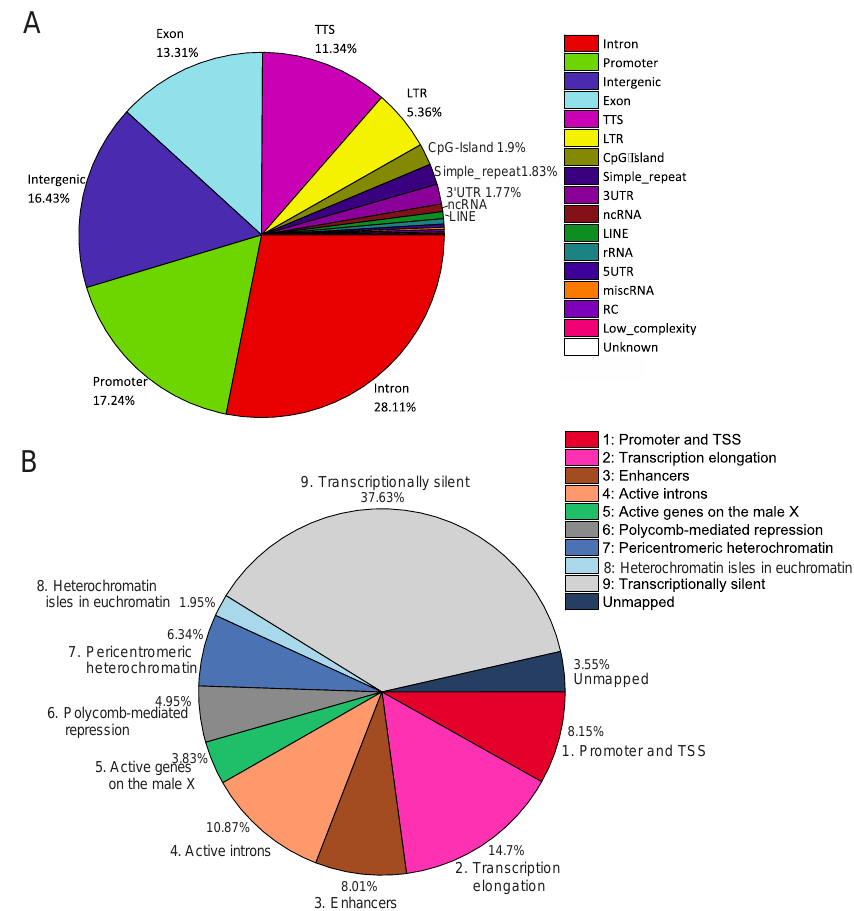
Figure 8. Genomic and epigenomic features at the nucleoli-contacting sites. ( A ) Distribution of rDNA-contacting sites in different portions of the Drosophila melanogaster genome. ( B ) Distribution of rDNA-contacting sites inside the different 9 major chromatin states (combinatorial patterns of 18 histone modifications) in S2 cells.